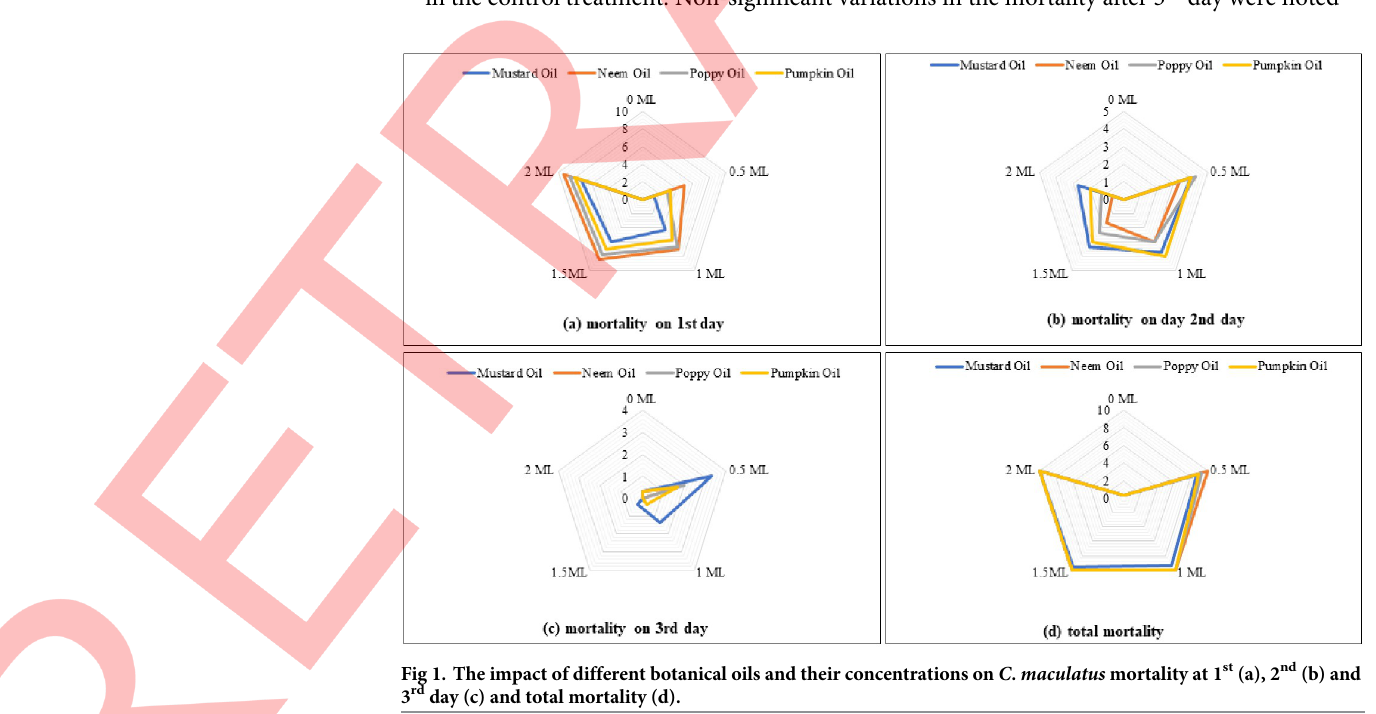
Fig 1. The impact of different botanical oils and their concentrations on C . maculatus mortality at 1 st (a), 2 nd (b) and 3 rd day (c) and total mortality (d).